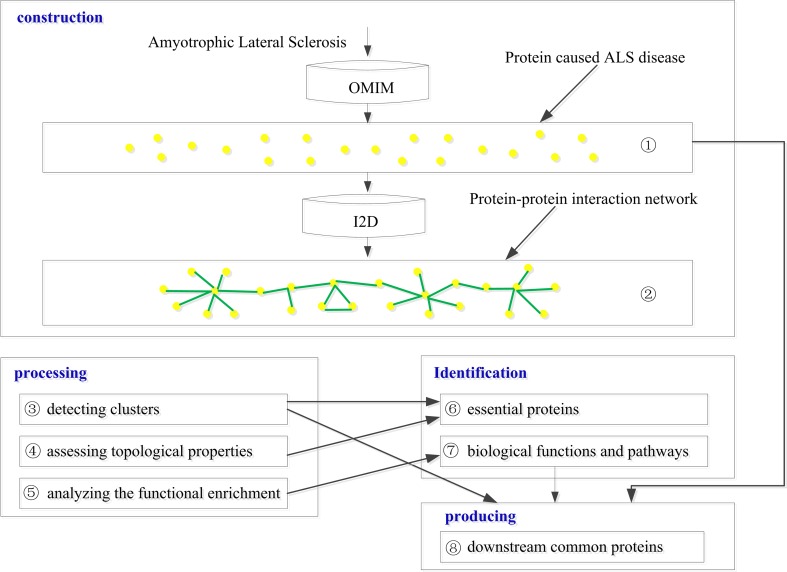
Overall work flow.